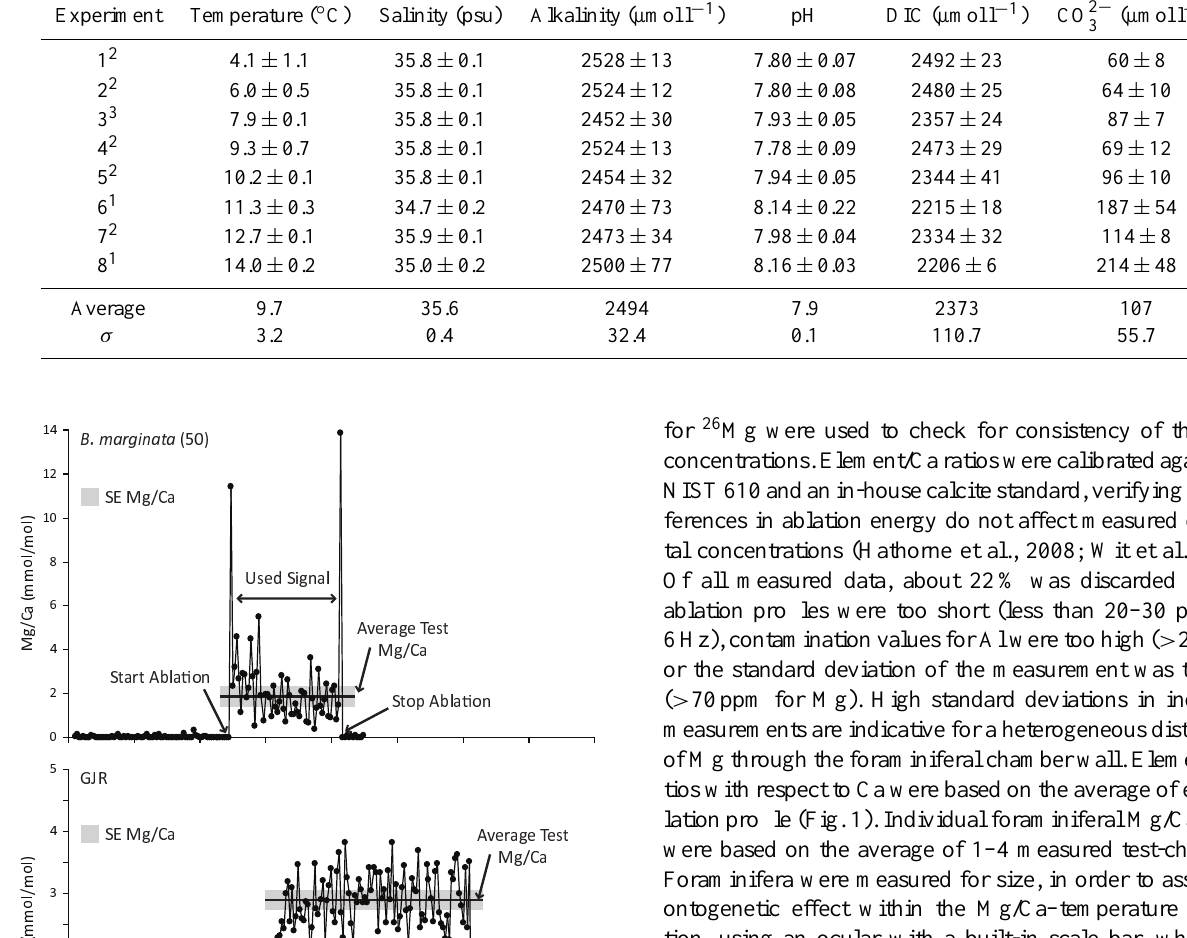
Table 1. Average and standard deviation of the main seawater parameters for all temperature experiments. Experiments contain samples from cultures at (1) Utrecht University, (2) University of Angers or (3) combined samples. Experiment Temperature ( ◦ C) Salinity (psu)